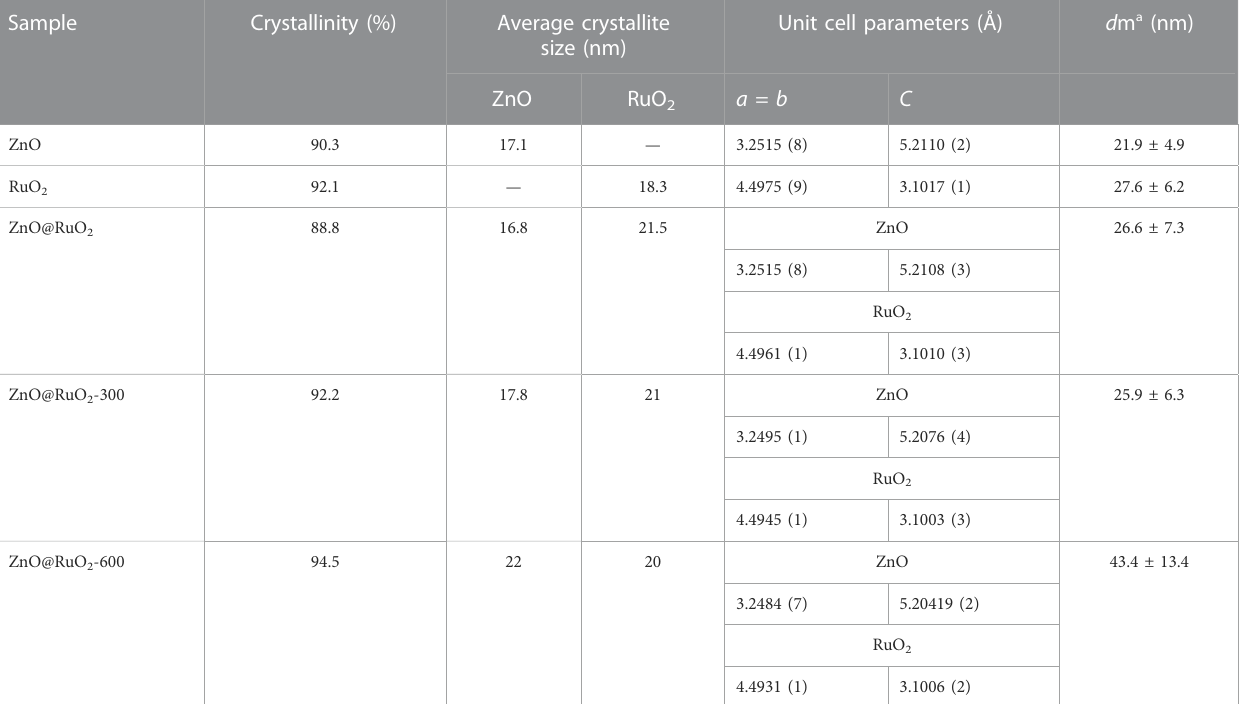
TABLE 1 Crystallinity values, average crystallite size, unit cell parameters with standard deviations, and mean particle size determined from the TEM images. Sample